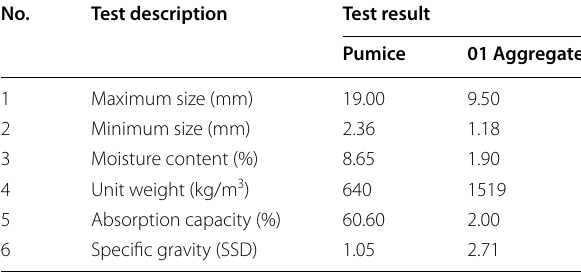
Table 2 Properties of coarse